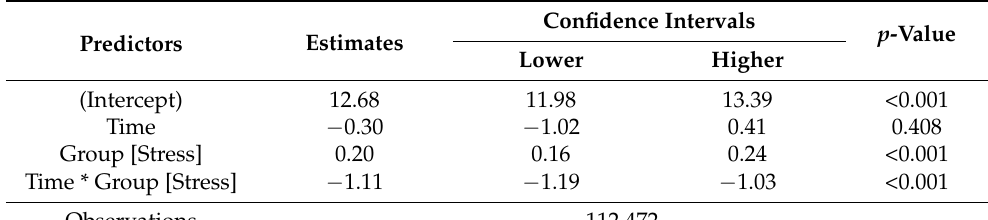
Table 5. Linear Mixed-Model Results for Respiratory Rate Parameter.